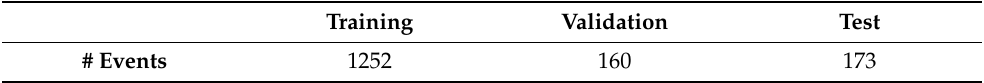
Table 3. Training, Validation and Test sets